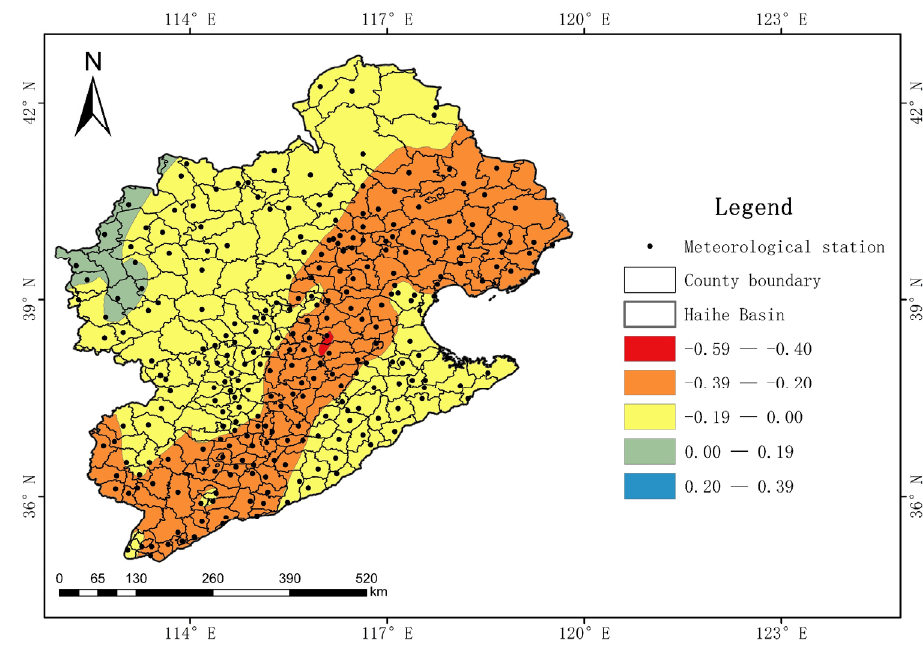
Figure 7. Spatial distribution of Spearman correlation coefficients at an interannual scale.